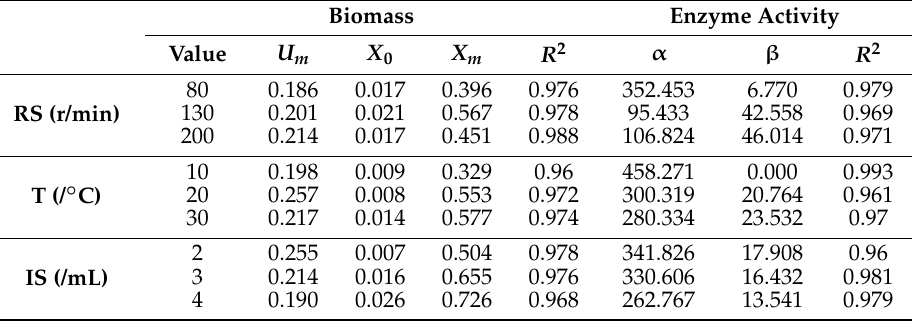
Table 6. Logistic’ model parameters U m (OD 600 /h), X 0 (/OD 600 ), X m (/OD 600 ) and Luedeking-Piret’ model parameters α and β coefficients of determination ( R 2 ) of fitted models for all the treatments. Biomass Enzyme